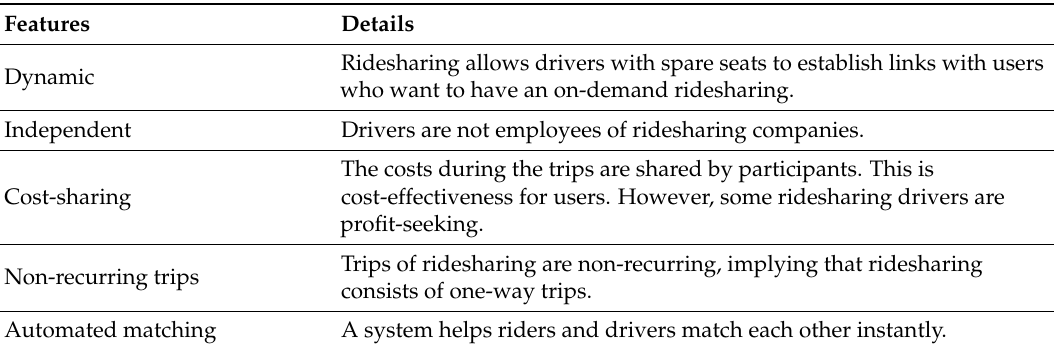
Table 1. The five features of ridesharing (based on